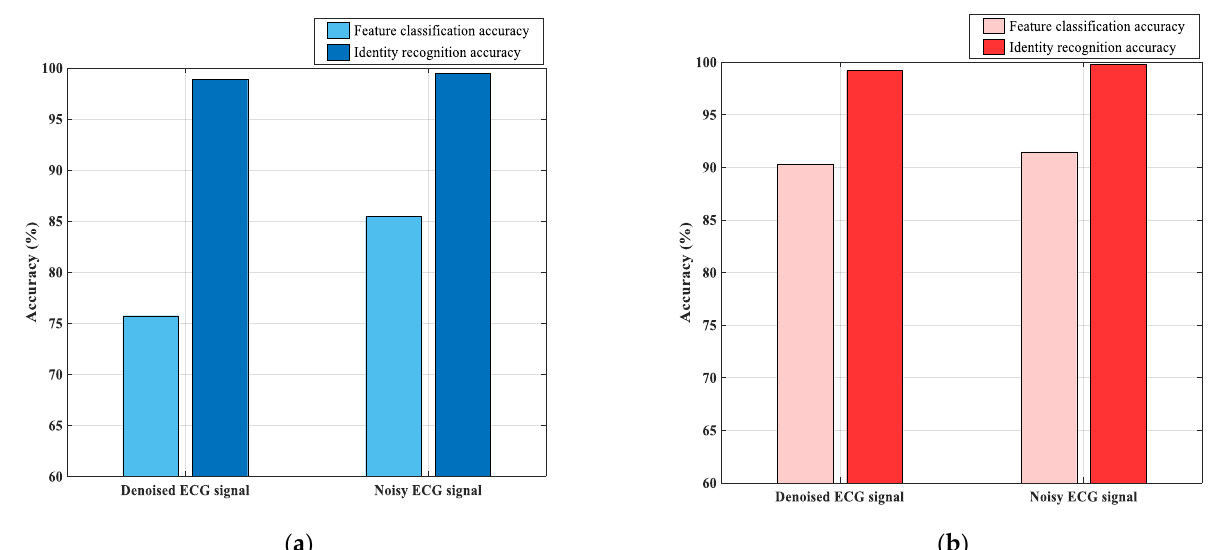
Figure 11. Comparison for recognition accuracy of denoised and noisy ECG signal. ( a ) Recognition performance comparison on ECG-ID database; ( b ) Recognition performance comparison on the mixed data set.